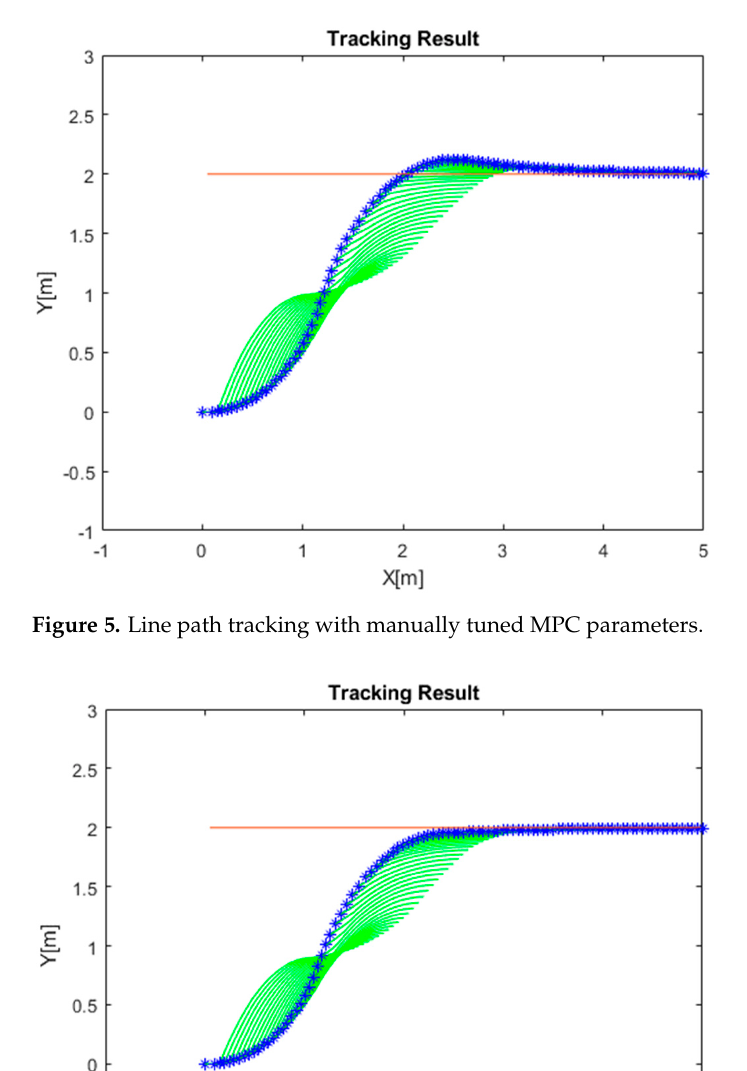
Figure 6. Line path tracking with RL-trained MPC parameters.